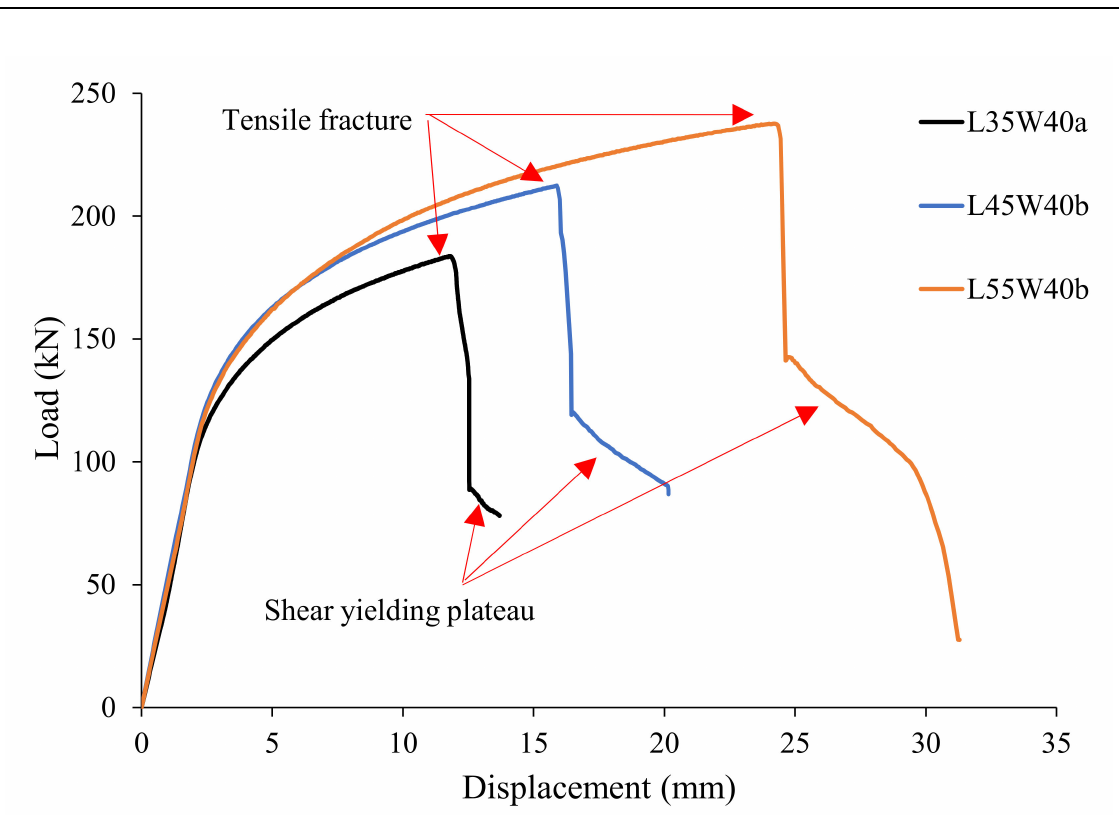
Figure 4. Load–displacement curves of the tested fillet welded